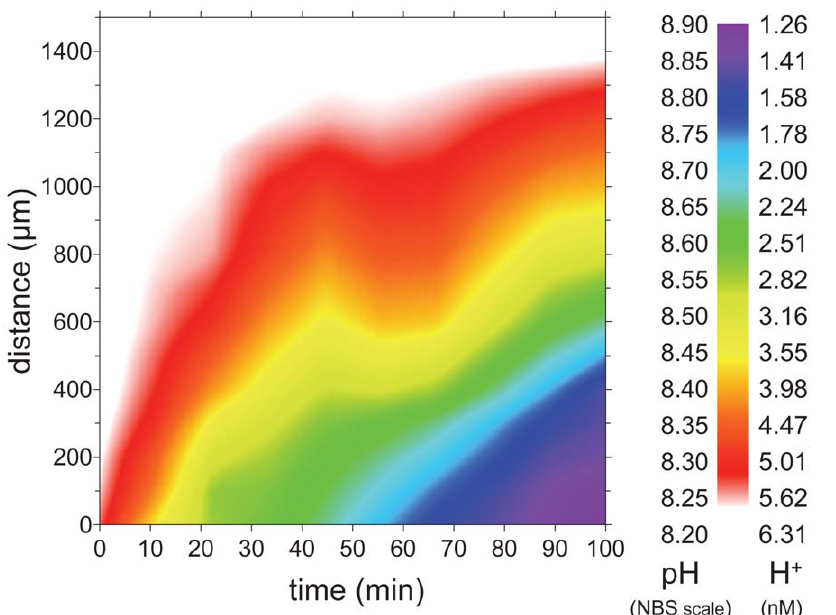
Figure 2. Temporal pH and H + development of diffusive boundary layer (DBL) of Marginoporavertebralis, measured consecutively at a single position on the calcite shell at a pCO 2 of 432 m atm, 30 m mol photons m 2 2 s 2 1 under zero flow conditions after flow (0.5 cm s 2 1 ) was cut off at time=0.